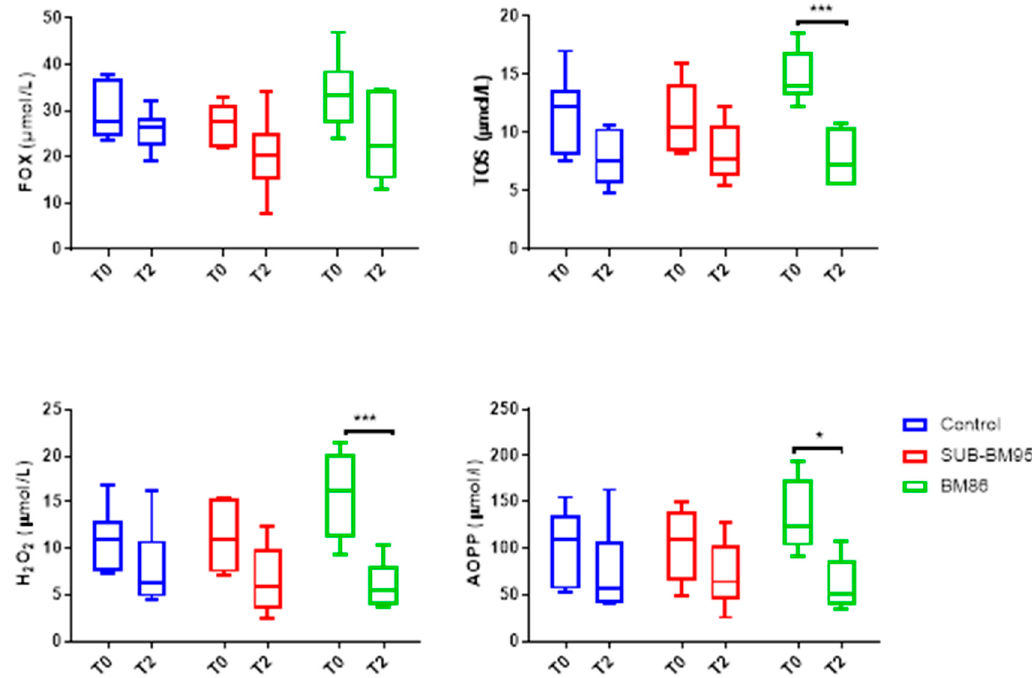
Figure 3. Values of oxidant markers in vaccinated cattle with BM86, SUB-BM95, and control at T0 and T2. FOX, ferrous oxidation-xylenol orange; TOS, total oxidant status; H 2 O 2 hydrogen peroxide; AOPP, advanced oxidation protein products. Asterisks indicate significant differences between times and immunization * p < 0.05, *** p < 0.001.